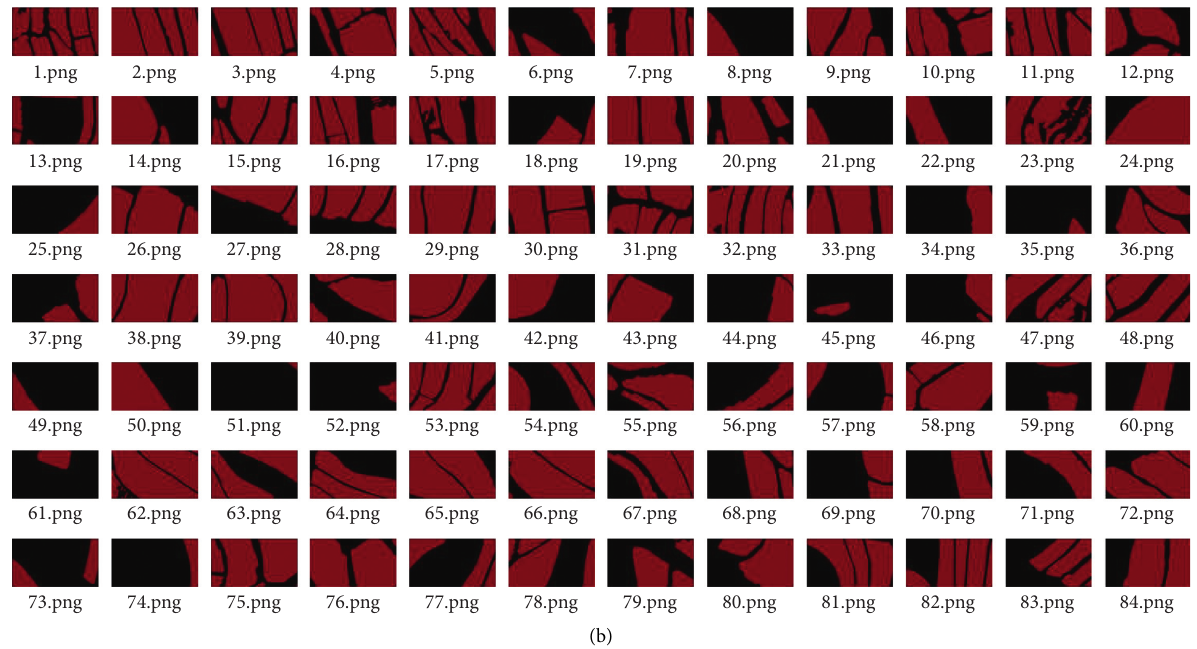
Figure 4: Dataset of semantic segmentation: (a) partial cropping data in dataset; (b) corresponding label data.